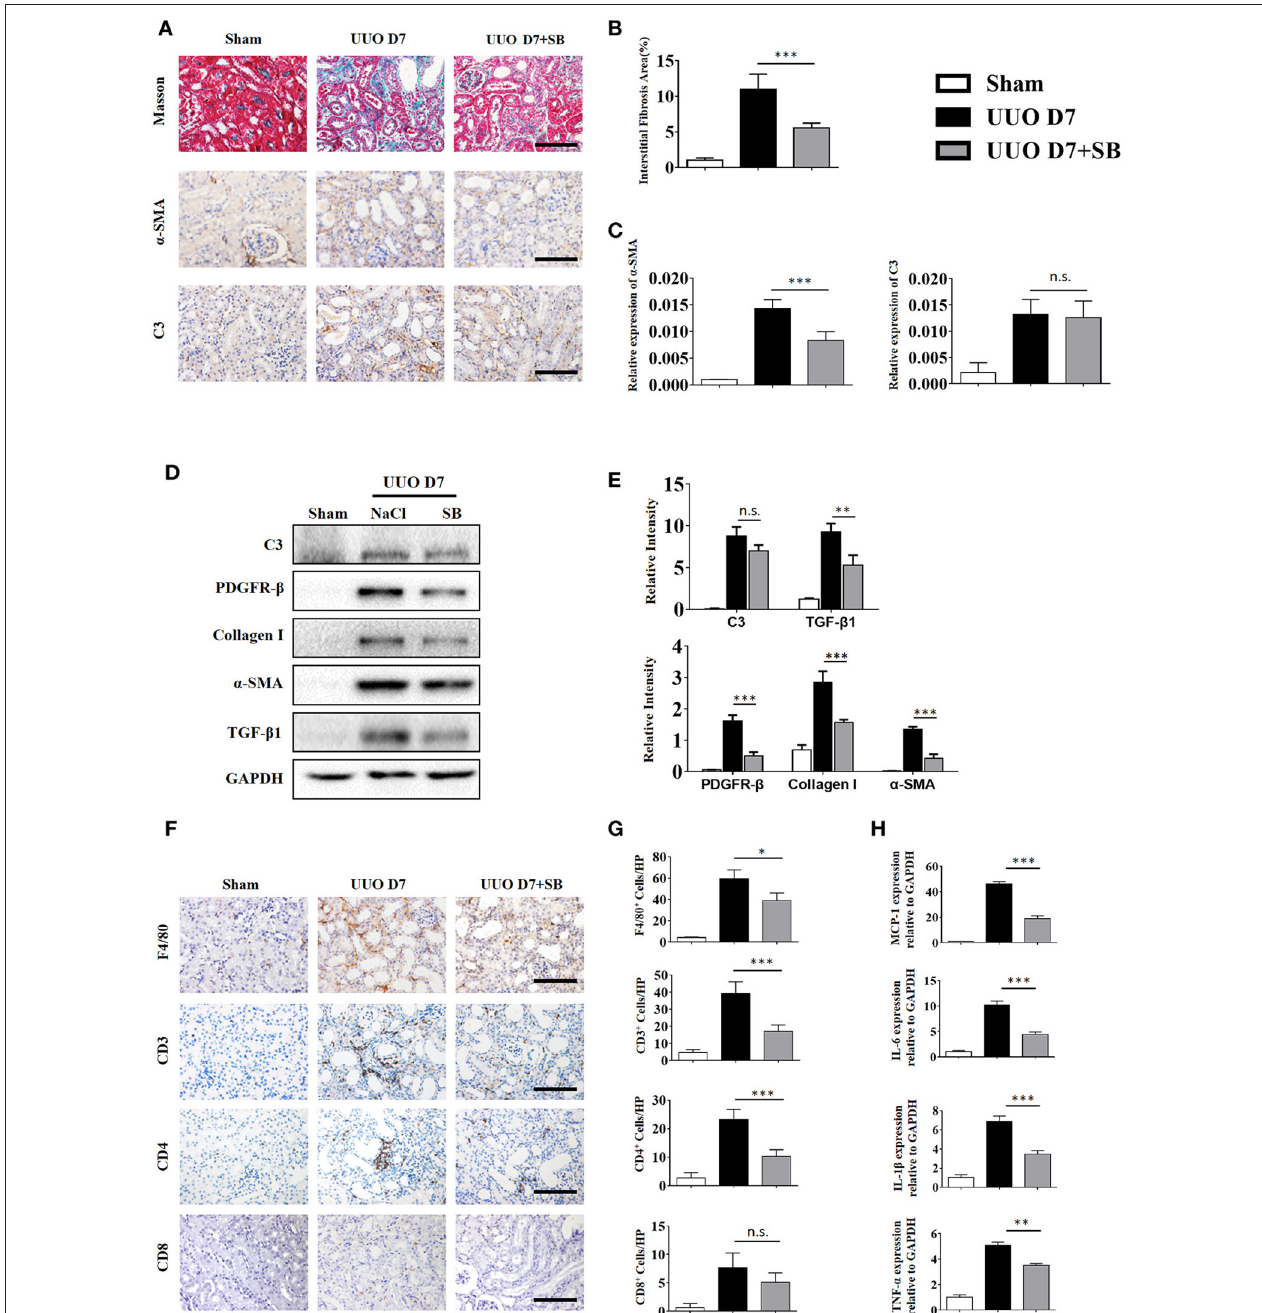
FIGURE 6 | C3aR blockade reduces inflammatory infiltration and fibrosis during UUO. UUO mice were intraperitoneally injected with vehicle and SB290157. On day 7, mice were sacrificed, and the left kidneys were collected. (A) Masson’s trichrome staining indicates collagen deposition. IHC staining showing α -SMA and C3 protein expression in these groups ( n = 6); original magnification, × 400. Scale bar, 50 µ m. Quantitative analysis of interstitial fibrosis (B) , a-SMA (C), and C3 positive cells (C) were shown as mean ± SEM. (D) The expression levels of C3, TGF- β 1, and fibrotic markers ( α -SMA, PDGFR- β , and Collagen I) were detected by Western blot. (E) The histogram shows the relative intensity for each marker normalized to GAPDH. (F) IHC staining showing F4/80 macrophages, CD3 + T cells, CD4 + T cells, and CD8 + T cells in these groups ( n = 6); original magnification, × 400. Scale bar, 50 µ m. (G) Quantitative analysis of F4/80, CD3, CD4, and CD8 positive cells were shown as mean ± SEM. (H) Real-time PCR showing relative renal levels of MCP-1, IL-6, IL-1 β , and TNF- α in these groups ( n = 6). The error bars represent the SEM. * P < 0.05; ** P < 0.01; *** P < 0.001.